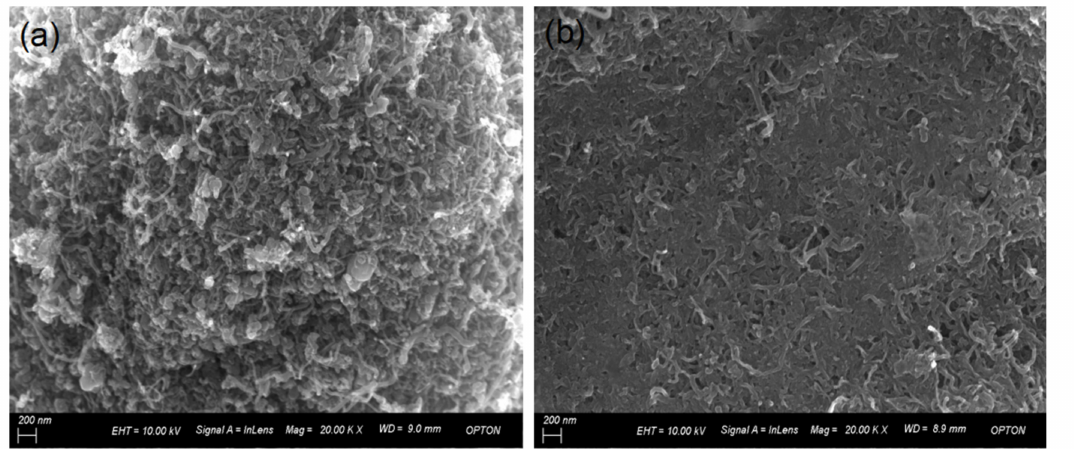
Figure 2. SEM images of the CNTs. ( a ) pristine CNTs, ( b ) acid treated